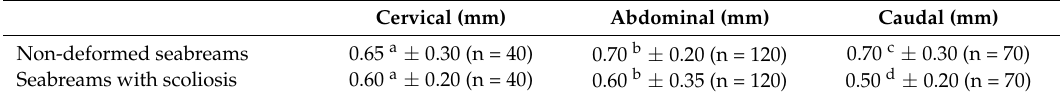
Table 3. Seabreams’ inter-vertebrae space mean lengths.